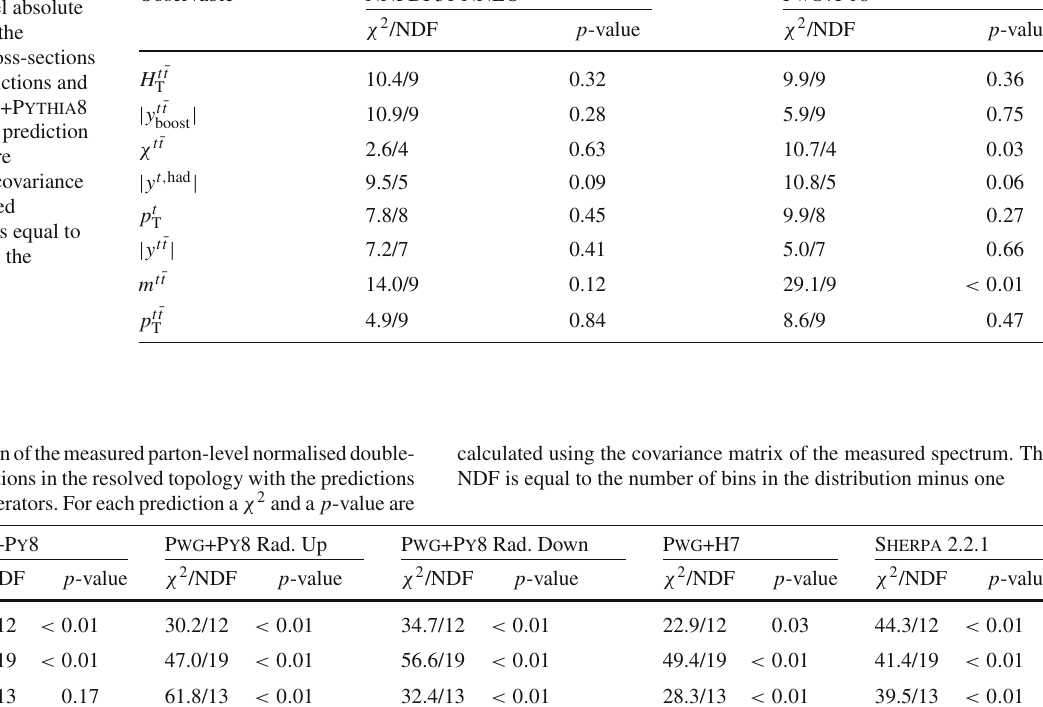
calculated using the covariance matrix of the measured spectrum. The NDF is equal to the number of bins in the